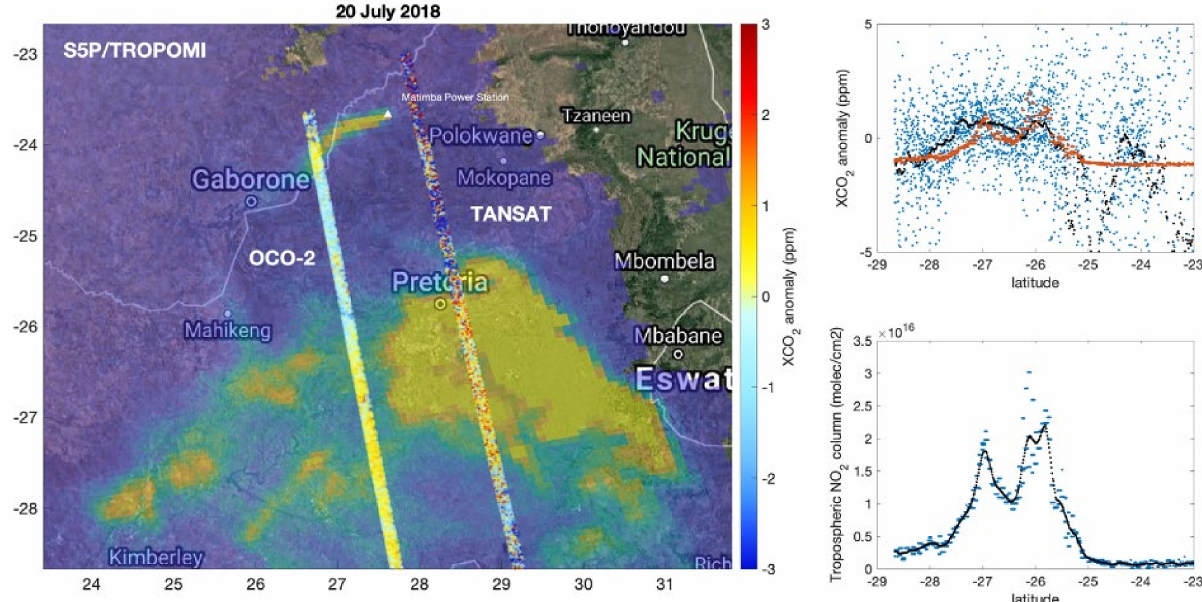
Figure 10. An example of the detection of anthropogenic plumes using TanSat, OCO-2 and Sentinel 5P satellites in Highveld area in South Africa, where several power plants are located. In the subpanels, we illustrate the cross-sections of the plumes along the TanSat track as a function of latitude. Blue colours indicate the TanSat XCO 2 anomalies ( top ) and TROPOMI tropospheric NO 2 columns ( bottom ). Black colours indicate the running mean. We also converted the observed tropospheric NO 2 columns to XCO 2 via linear fit (orange colours,